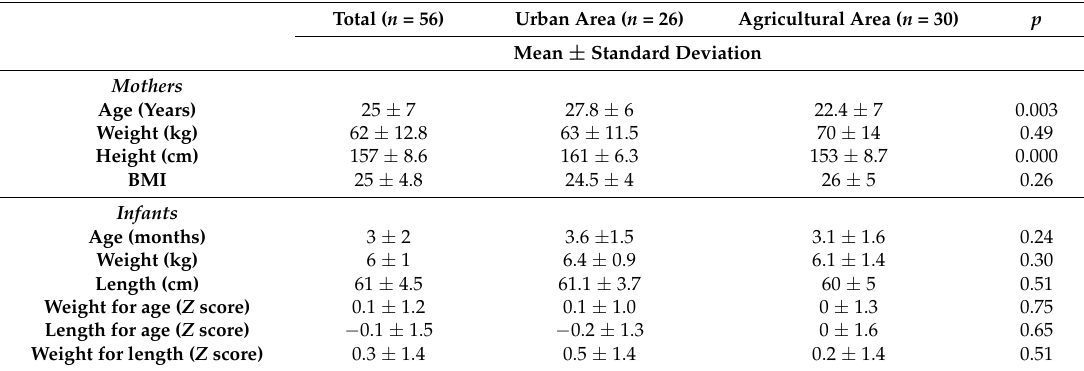
Table 1. General characteristics of participant mothers and